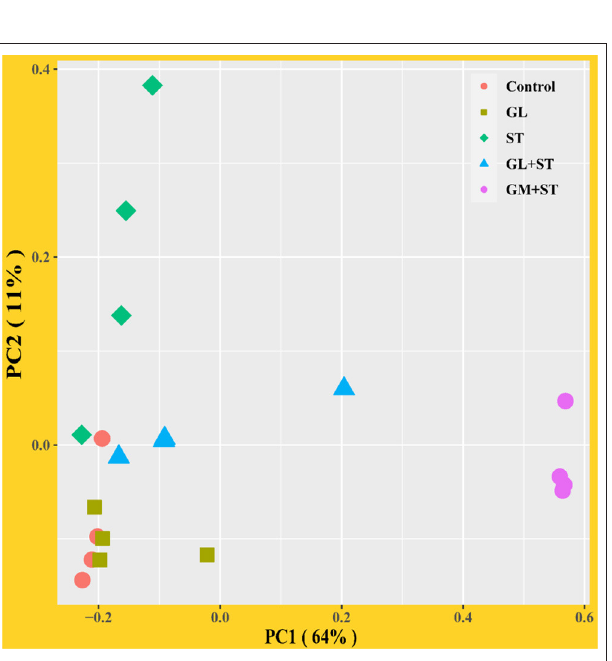
group, Ruminiclostridium 9, and Lachnospiraceae UCG- 001. ST infection significantly ( P < 0.05) increased the relative abundance of Alphaproteobacteria , Verrucomicrobiales ,